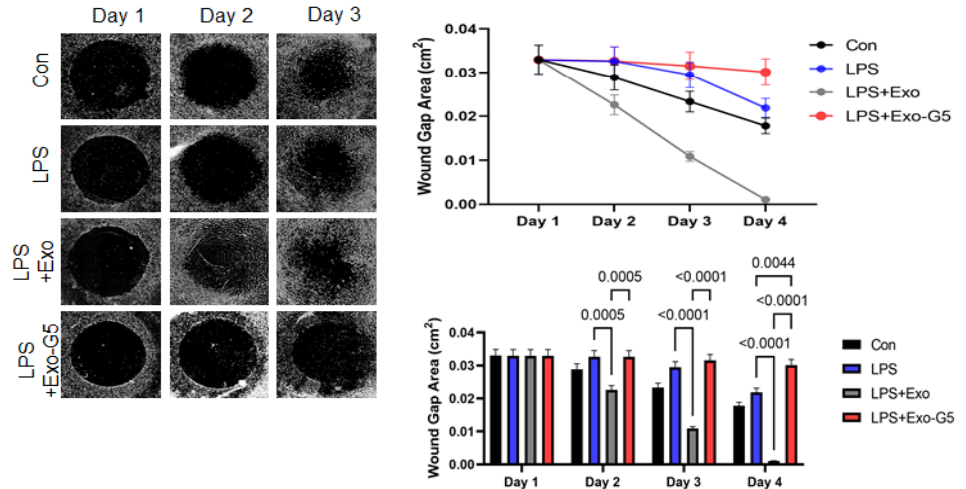
Figure 6. HDF cells were grown on a collagen scaffold to mimic 3D wound healing. Chronic inflammation was induced for 4 days using 5 ng/mL LPS for 6 h followed by treatment with hASC exosomes (Exo) or exosomes depleted of GAS5 (Exo-G5) for 18 h. LPS was maintained in the media along with the treatment. The 3D wound model was maintained at 37 °C and wound closure was imaged every 24 h using a Keyence BX810 microscope ( n = 3). Wound closure was calculated each day using a Keyence’s Cell migration assay with Hybrid cell count software to calculate wound gap area. Statistical analysis was performed by one-way ANOVA and significant p -values (<0.05) are indicated on the graph.